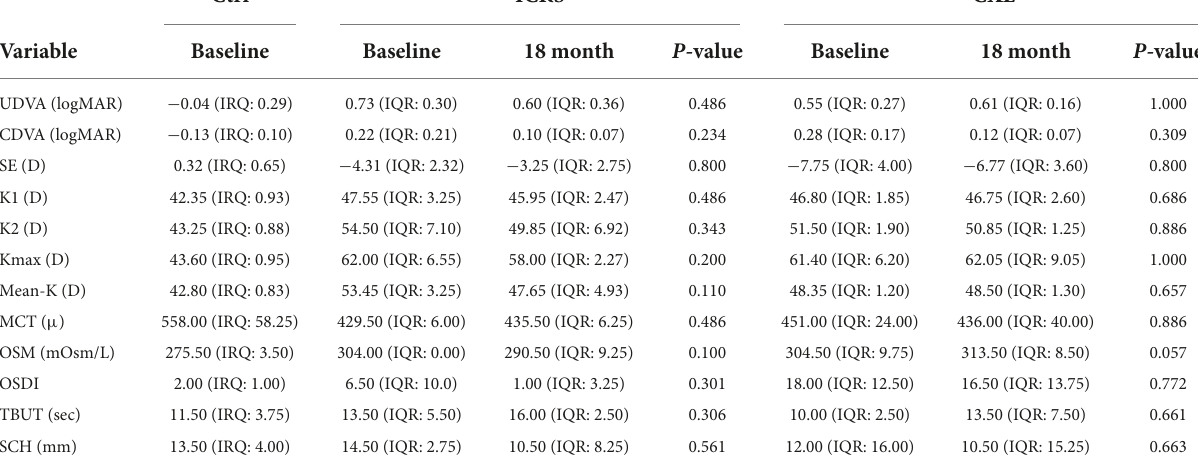
TABLE 1 Comparison of results after treatment with baseline values. Ctrl ICRS CXL Variable Baseline Baseline 18 month P -value Baseline 18 month P